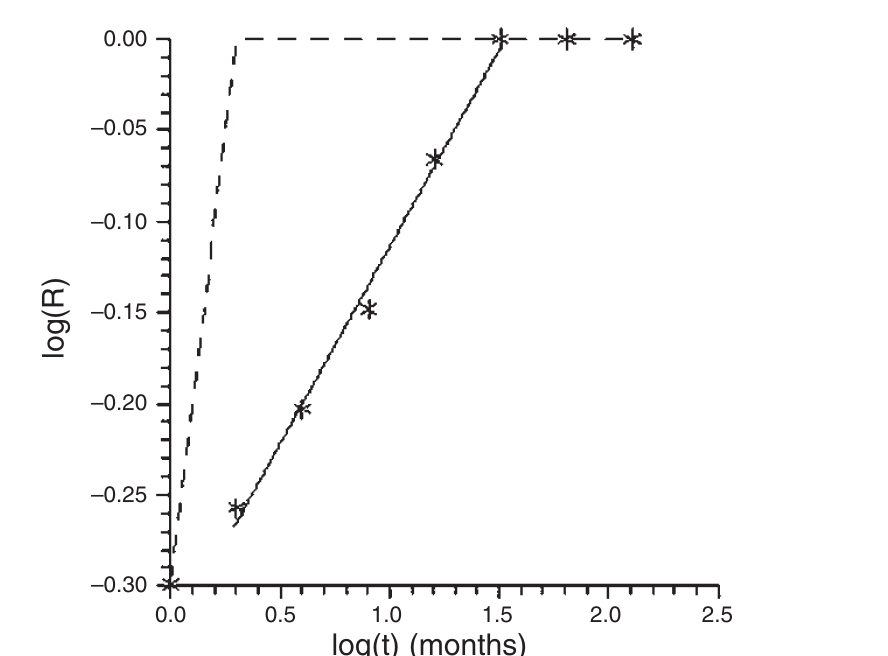
Fig. 3. The logarithm of the fraction R of time intervals of length (in months) including at least one event with SI ≥ 1 as a function log( t ). The dashed line represents the relative random